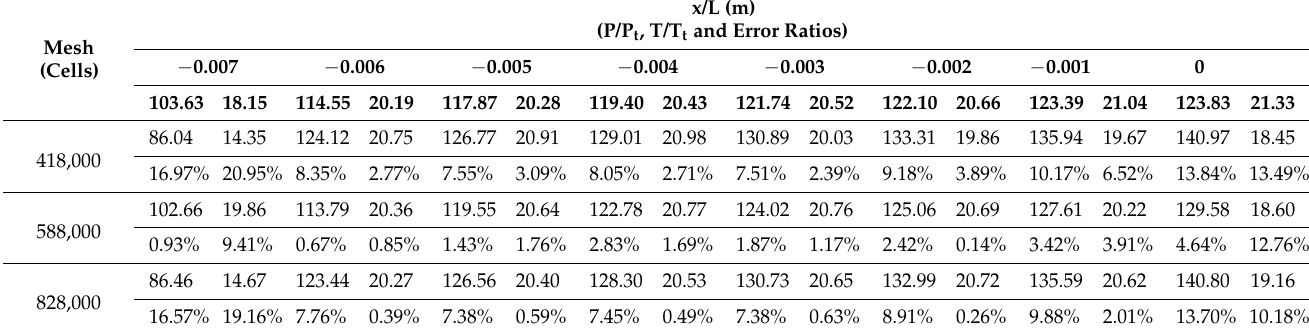
Table 1. Three different level meshes with error ratios at a far-field distance of 12 m for grid independency.